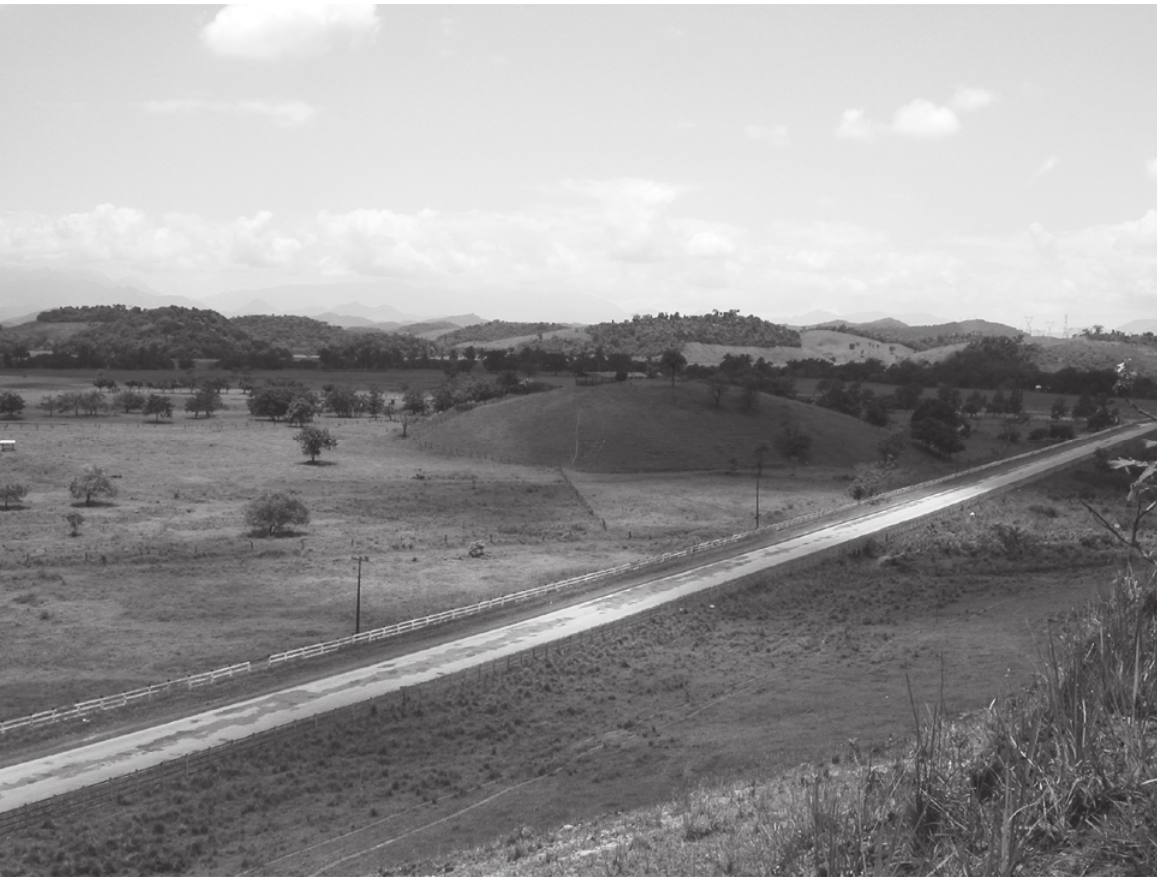
Figure 8 - Agricultural landscape dominated by pastures and small forest fragments on the ”half oranges” in the municipality of